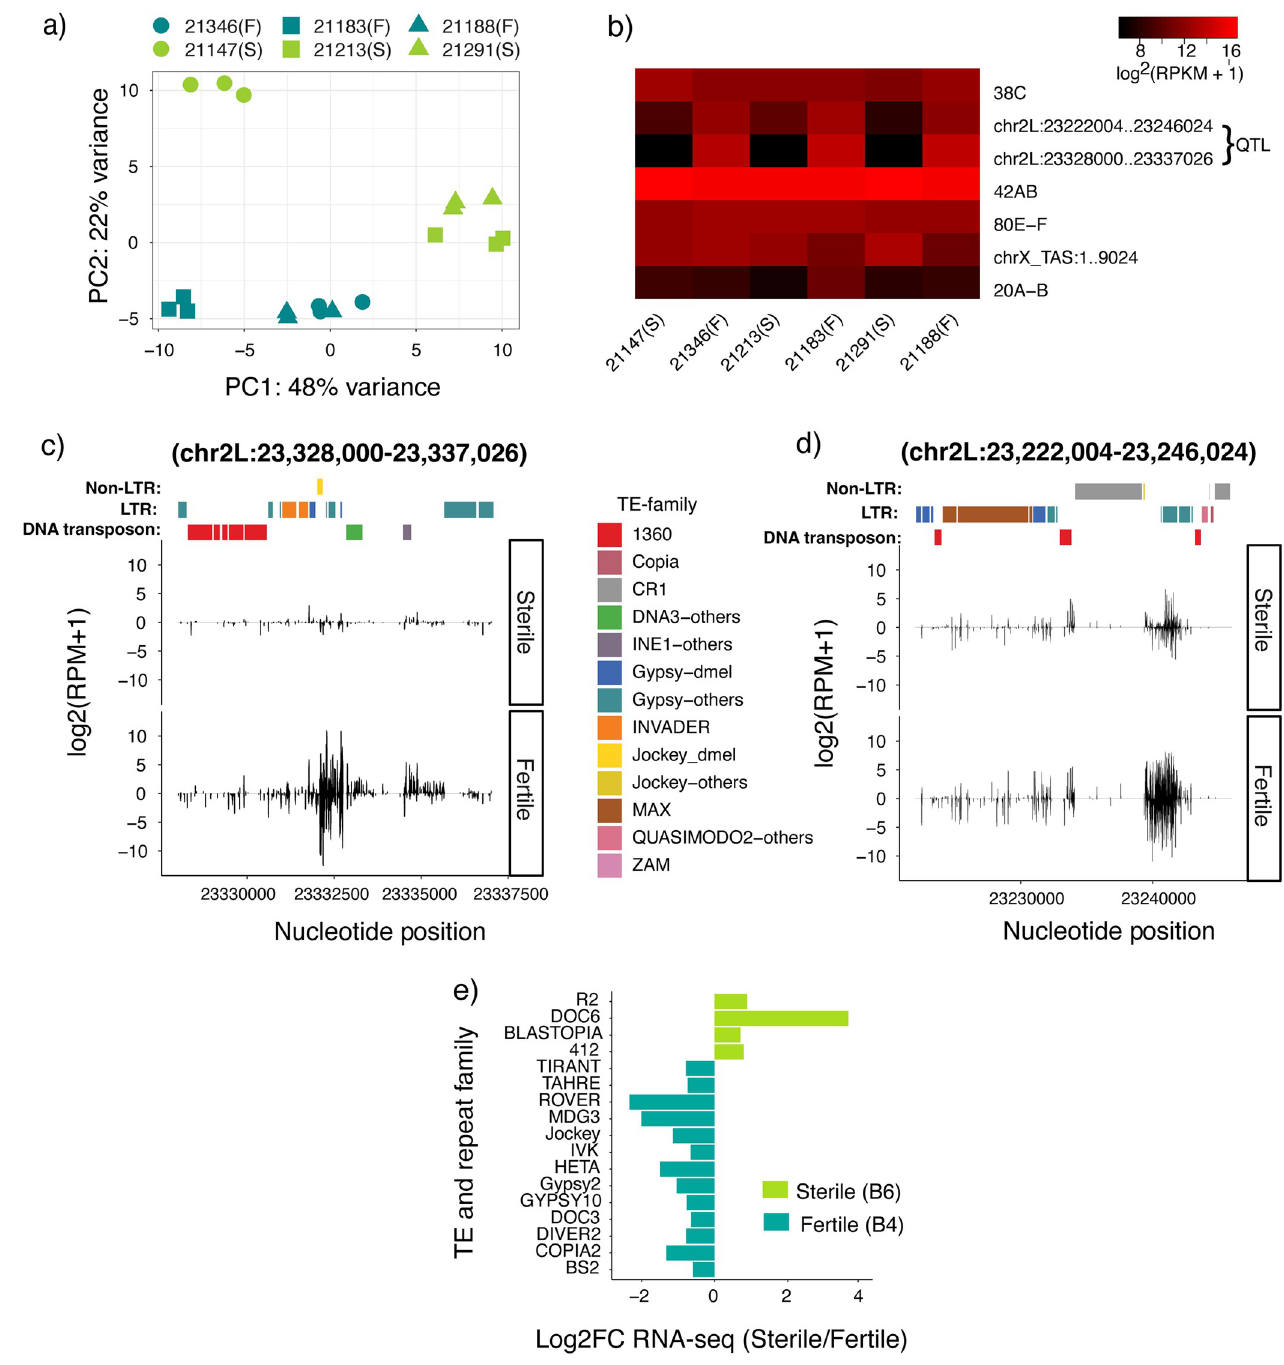
Fig 3. Dysgenic sterility is not related to differential activity of piRNA clusters or TE deregulation. a ) PCA analysis for piRNA cluster expression data of sterile (S) and fertile (F) genotypes. Members of the same RIL pair are represented by the same shapes. b) Heat map showing the expression of seven major piRNA clusters [61] and the two differentially expressed QTL clusters in QTL-3d. RIL pairs are plotted adjacent to each other. c and d) Uniquely mapping piRNAs within two differentially active QTL-3d piRNA clusters are compared between sterile (21183) and fertile (21213) genotypes. Positive value indicates piRNAs mapped to the sense strand of the reference genome and negative value indicates those from the antisense strand. TE insertions in each cluster are presented according to family by different colors; TE-others indicate the insertion was most similar to a consensus TE from a sibling species of D . melanogaster . See S2 and S3 Figs for cluster expression in the remaining RIL pairs. For b, c and d, piRNA cluster expression levels are estimated by log2 scale transformed of reads per million mapped reads [log2(RPM+1)]. e) Genome-wide differences in TE family expression between sterile and fertile genotypes (fold change = 1.5, base mean > = 100, adjusted p- value < = 0.05), based on alignment to consensus sequences. The data used to plot panel a is provided in S15 Table, for panel b in S8 Table , for panels c and d in S16 and S9 Tables , and for panel e in S10 Table ). https://doi.org/10.1371/journal.pgen.1010080.g003 PLOS Genetics | https://doi.org/10.1371/journal.pgen.1010080 December 7,